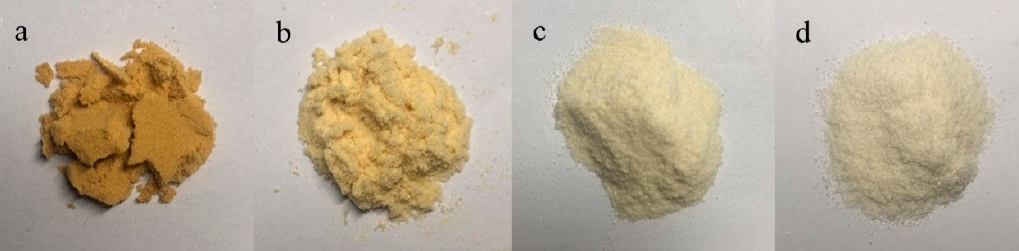
Figure 2. The morphologies of chitosan with different molecular weights: ( a ) 2 − 3 kDa chitosan; ( b ) 3 − 6 kDa chitosan; ( c ) 10 kDa chitosan; ( d ) 100 kDa chitosan.